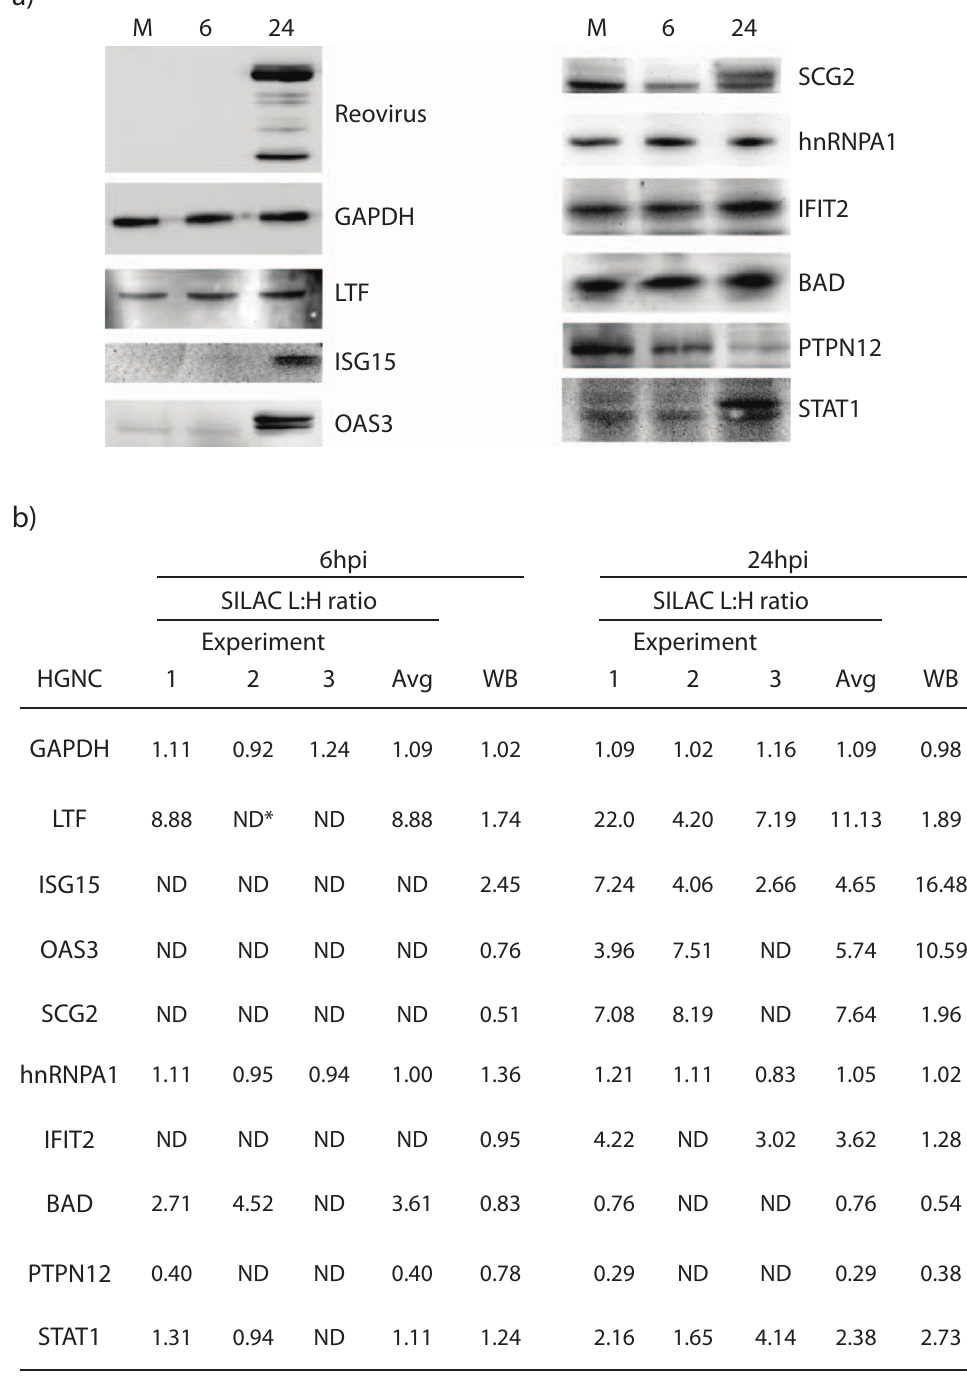
Figure 4. Validation of SILAC-determined protein abundances. (a) Western blot analyses of selected proteins. Mock-infected and T1L- infected cells were harvested at 24hpi, lysed with 0.5% NP-40, and 20–80 m g of each cytosolic fraction resolved in each lane of 10 6 6.5 6 0.1 cm 10% SDS-mini-PAGE. Proteins were transferred to PVDF membranes, blocked, probed with various indicated primary antibodies, developed with appropriate secondary antibodies, and visualized with an Alpha Innotech FluorChemQ MultiImage III instrument. (b) Densitometry analysis comparison to SILAC L:H average ratios for the ten different host proteins in (a). Most of the Western blot results correlated to the regulation of the proteins observed in SILAC (whether or not they are up or down regulated). All of the proteins tested by Western blot were also identified at 24hpi in SILAC and were therefore used for confirmation. Some of these proteins were also identified at 6hpi in SILAC and these were used for WB comparison. (GAPDH – glyceraldehyde-3-phosphate dehydrogenase, LTF – lactotransferrin, ISG15 – interferon-stimulated protein 15kDa, OAS3 – 2 9 – 5 9 oligoadenylate synthetase 3, SCG2 – secretogranin II, hnRNPA1 – heterogeneous nuclear ribonucleoprotein A1, IFIT2 – Interferon-induced protein with tetratricopeptide repeats 2, BAD – Bcl-2 binding component 6, PTPN12 – protein tyrosine phosphatase, non-receptor type 12, STAT1 – signal transducer and activator of transcription 1). doi:10.1371/journal.pone.0051939.g004 PLOS ONE |